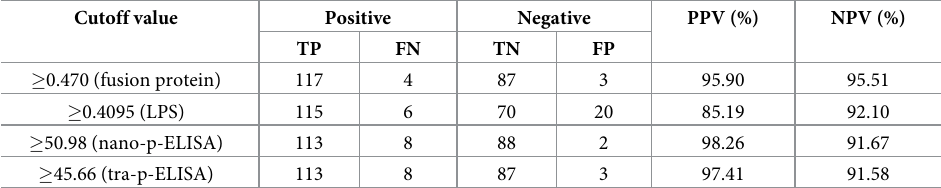
Table 2. Positive and negative predictive values of the test calculated for different cutoff